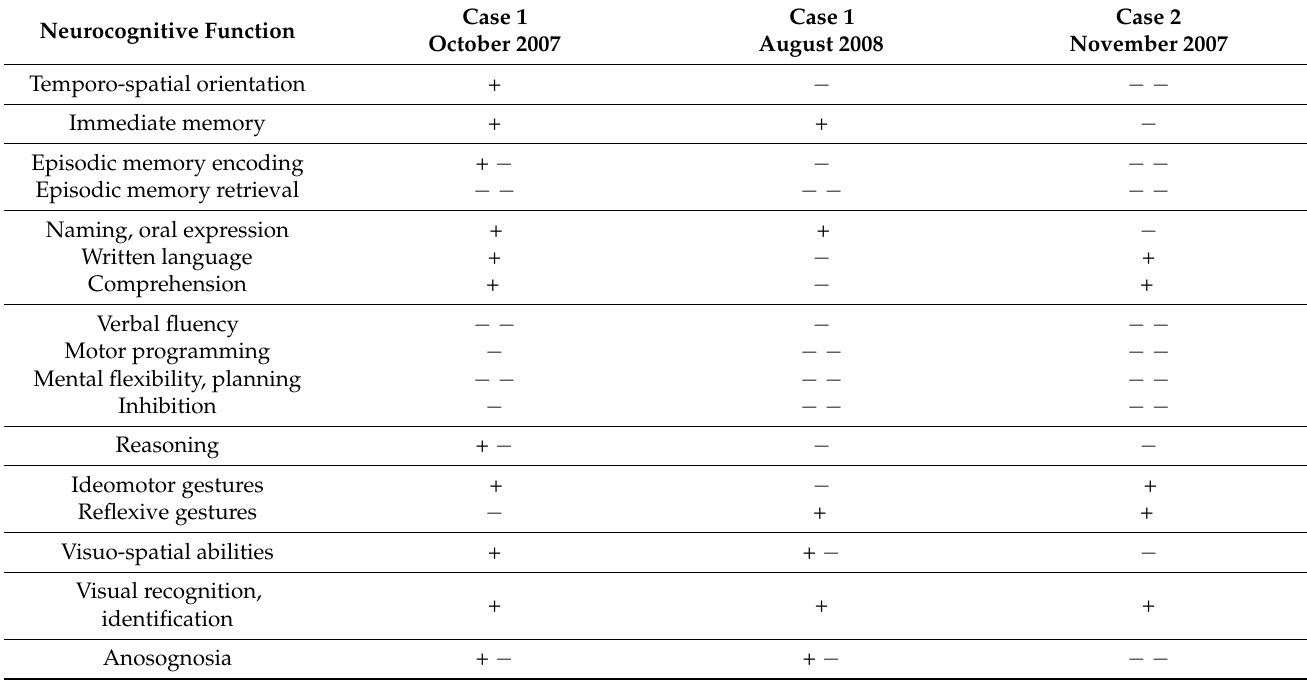
Table 1. Comparative neurocognitive assessments of the two reported